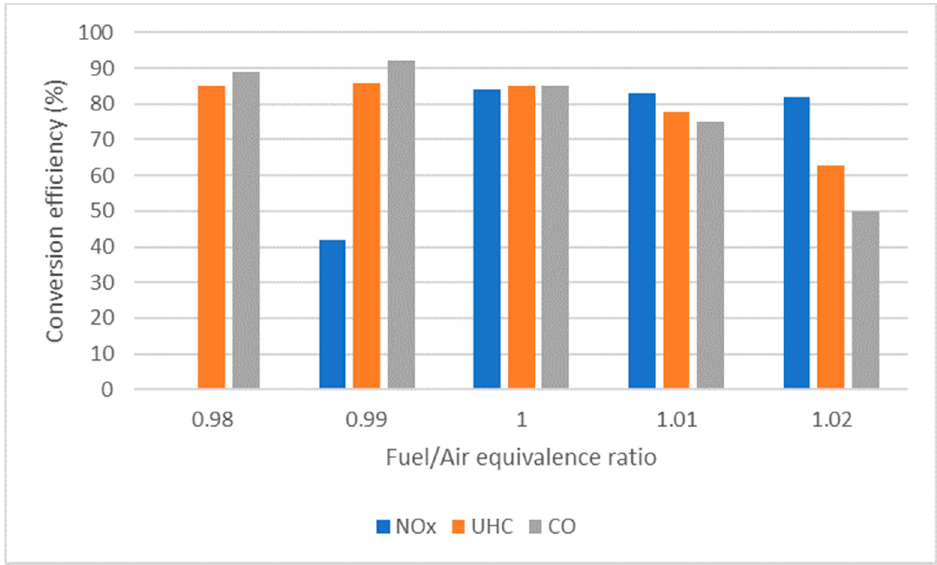
Figure 9. Window for operation of the three-way catalytic converter. Adapted from [14].